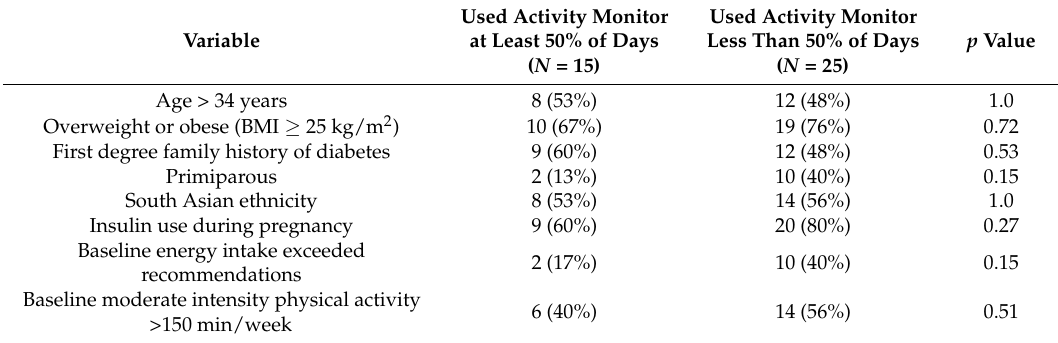
Table 4. Predictors of activity monitor use amongst intervention subjects.